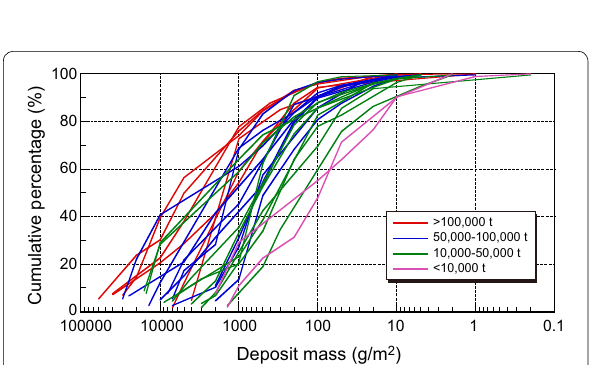
Deposit mass (g/m 2 ) Fig. 9 Cumulative percentages of erupted mass of the 2014–2015 Nakadake ash-fall